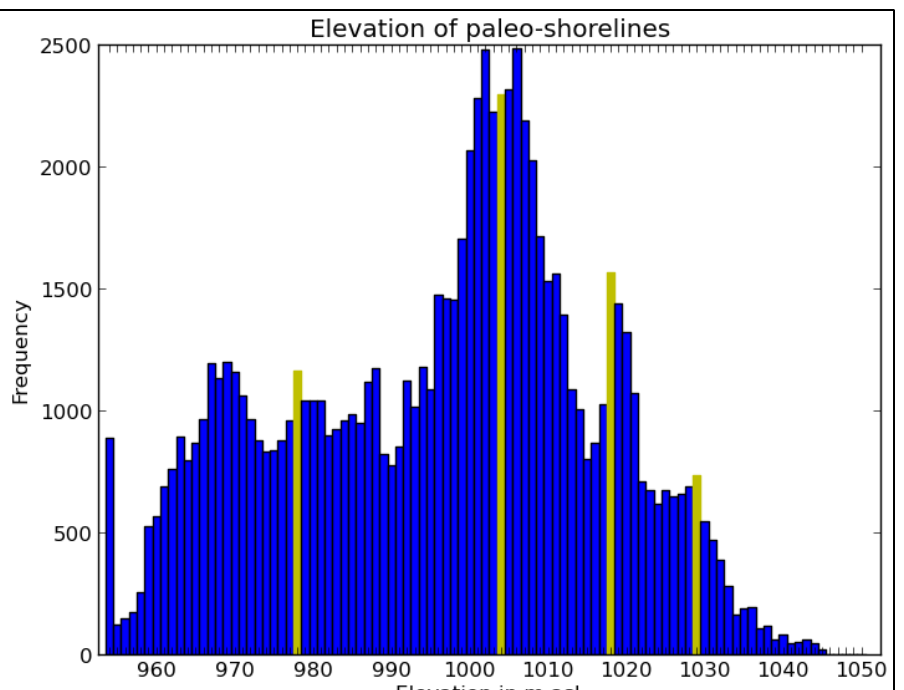
Figure 5. Histogram of paleo-shoreline height level distribution. Yellow bars indicate the lake levels visualized in Figure